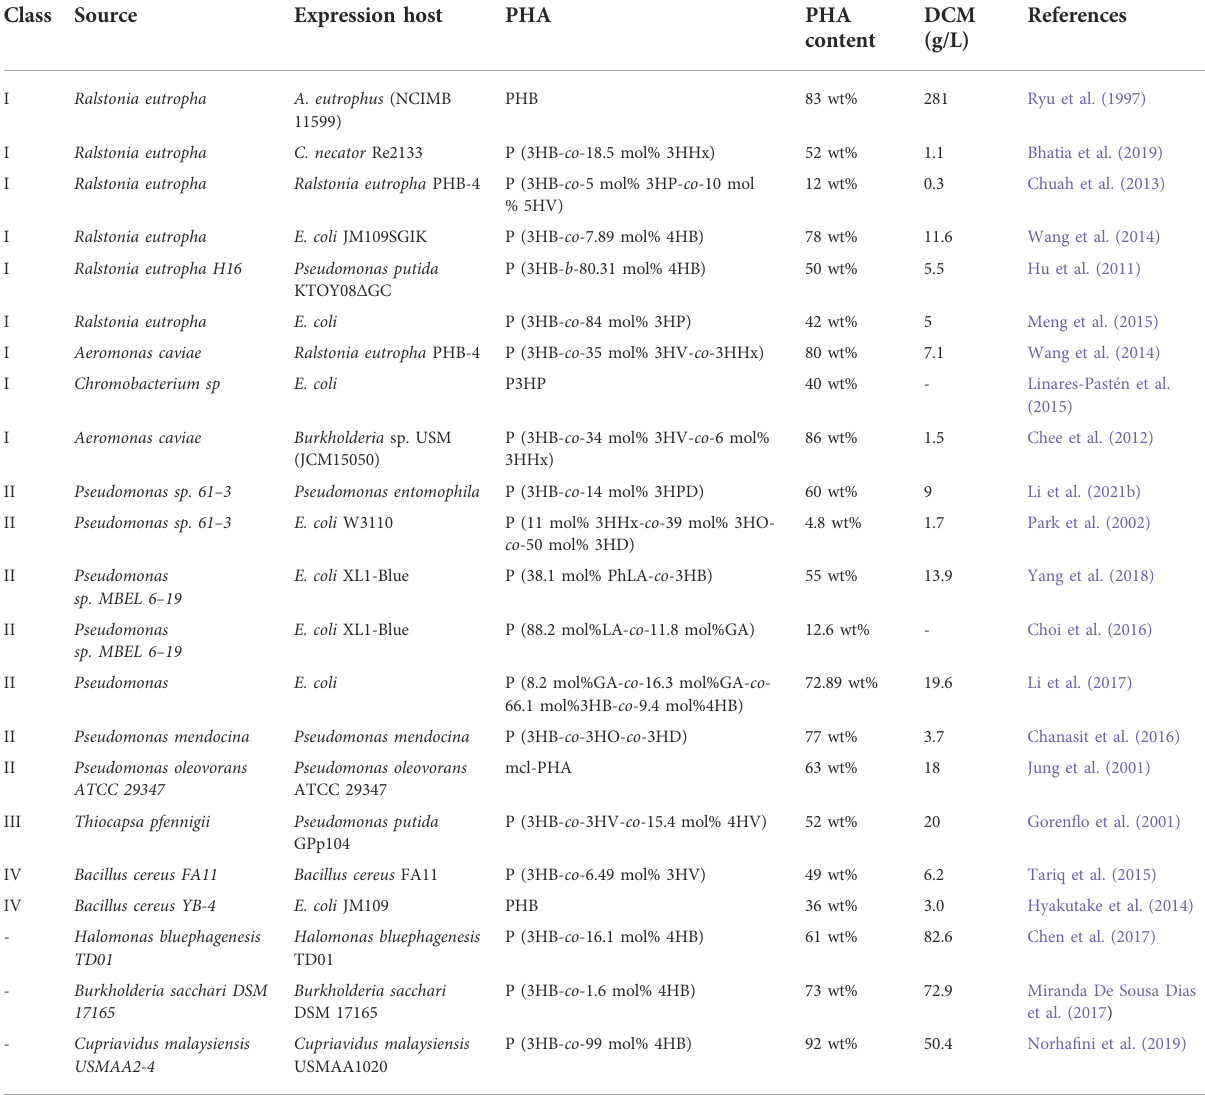
TABLE 1 Different PHA synthases identi fi ed from natural PHA producing